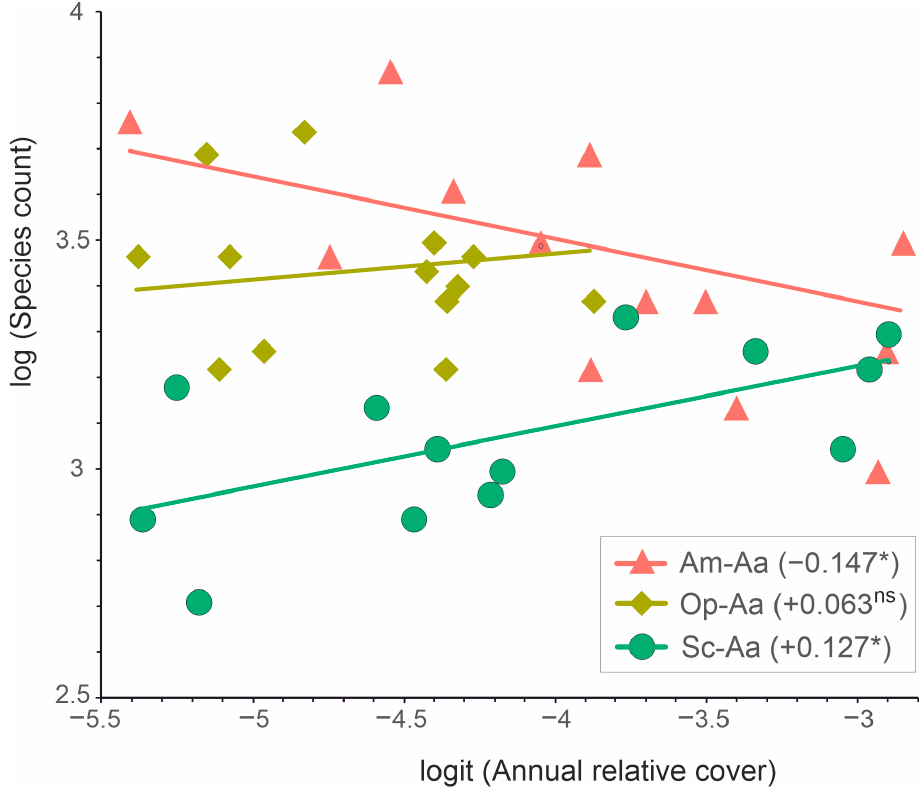
Figure 10. Spatially conditioned linear fi t of (log-transformed) species richness against (logit-transformed) annual relative cover in each of the three Artemisia alba -(co)dominated communities distinguished in the Carpathian and Pontic regions. The numeric values between parentheses represent the slopes of the fi tt ed lines (0.01 < p * < 0.05; ns = non-signi fi cant). Abbreviations as in Figure 2.